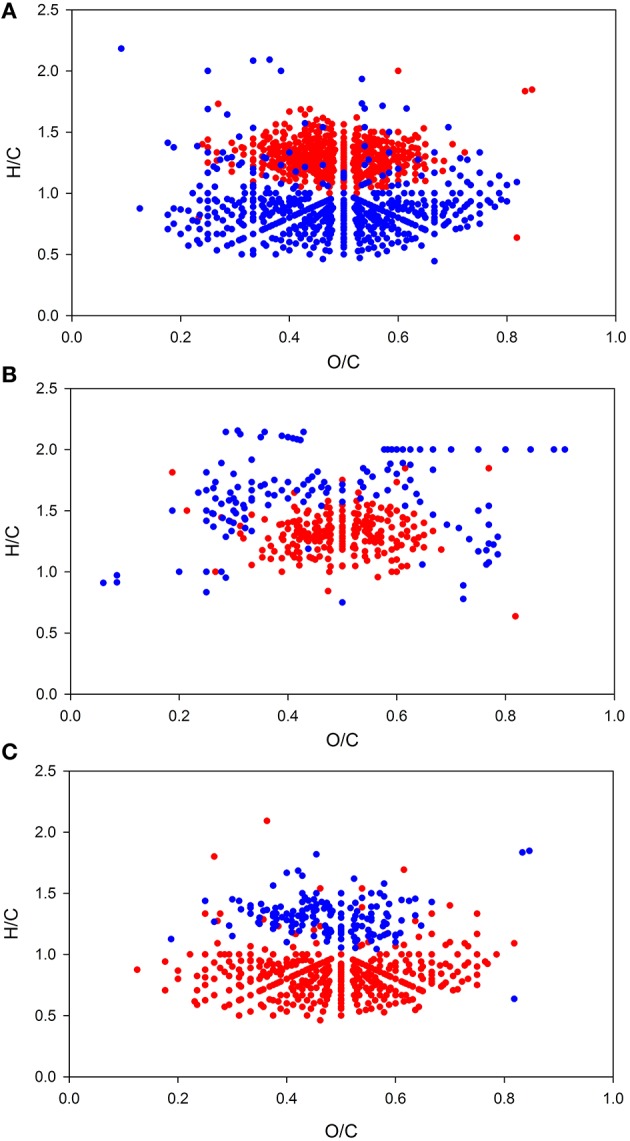
Van Krevelen plots of DOM molecular formulae with relative intensity correlating significantly (p < 0.05) with salinity (A), temperature (B), and dissolved organic carbon concentration (DOC) (C). Molecular formulae showing positive correlations are depicted in red; formulae with negative correlations are shown in blue.